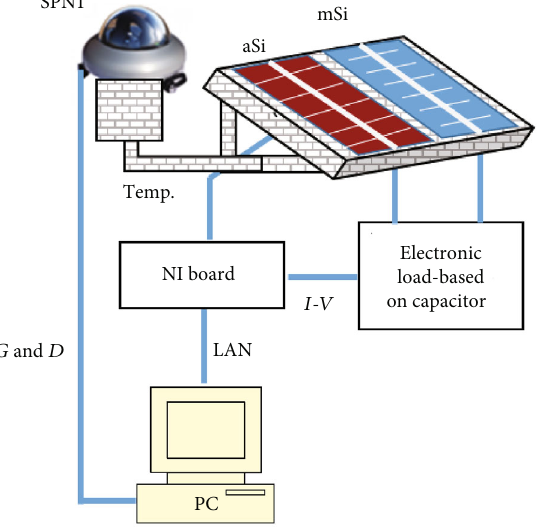
Figure 1: System setup with the two commercial photovoltaic